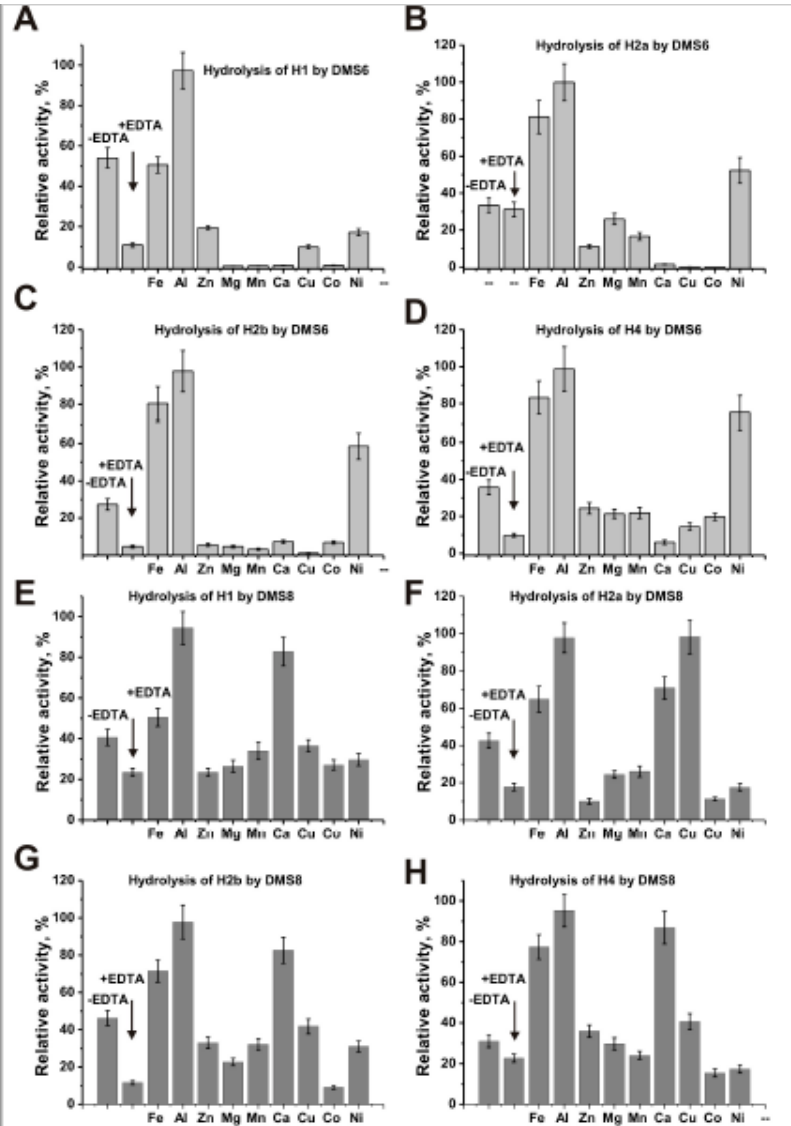
Figure 3. Typical examples of a decrease in histones-hydrolyzing activity of two individual IgGs (DMS6 and DMS8) after their dialysis against EDTA and then the activation of dialyzed IgGs by di ff erent metal ions at fixed 2 mM concentration ( A – H ). A complete hydrolysis of every histone in the presence of 0.66 µ M IgGs for 12 h was taken for 100%. Diagrams corresponding to various metal ions are marked in panels A – D (DMS6) and E – H (DMS6); used metal ions are listed on these panels. The di ff erences between di ff erent groups were estimated: the significant di ff erence ( p = 0.036) was found only between the hydrolysis of H4 by DMS8 and H2b by DMS6, in other cases, p was higher than 0.05. For details, see Materials and Methods.